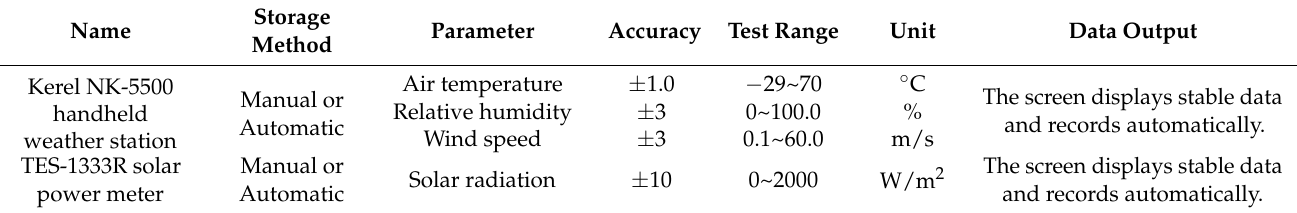
Figure 6. The photo of the Kerel 5500 handheld weather station ( a ) and the TES-1333R solar power meter ( b ). Table 2. Specification of the equipment.